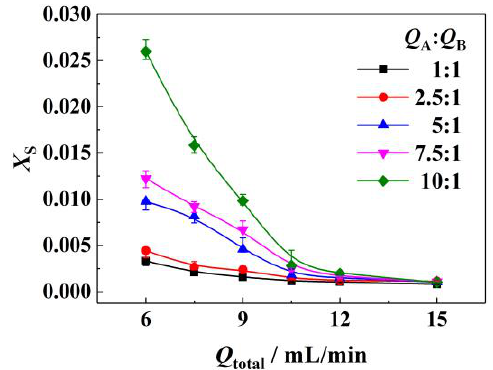
Figure 5. Influence of the ratio of flow rates on micromixing performance. Reference conditions: micromixer, 0.25 mm of I.D.; connecting pipe, 0.5 mm of I.D., 5 cm of length; micropacked bed, 5 cm of length; packing size, 0.177~0.250 mm; μ A = 10 mPa·s, μ B = 1 mPa·s.